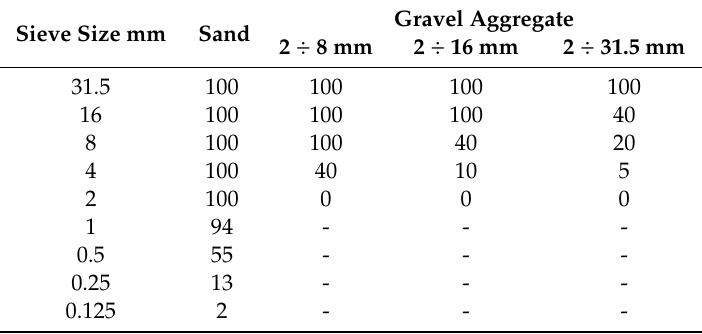
Table 3. Sieve analysis of the fine and coarse aggregates,